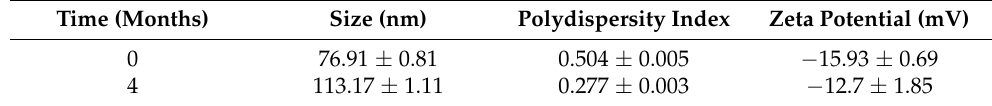
Table 4. Stability profile of transferosomes.